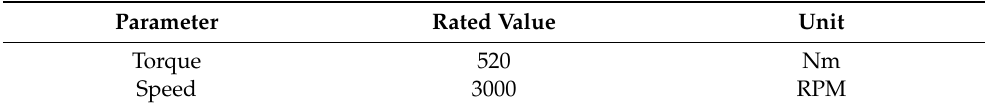
Figure 6. Power demand for EPA’s non-road transient cycle (NRTC). Table 1. Rated torque and speed for the electric motor.